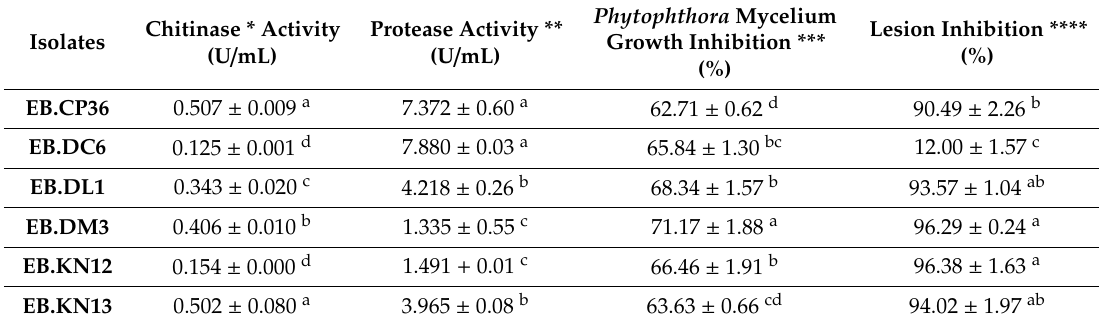
Table 3. Relationship between enzymatic activity and Phytophthora antagonism in vitro and in